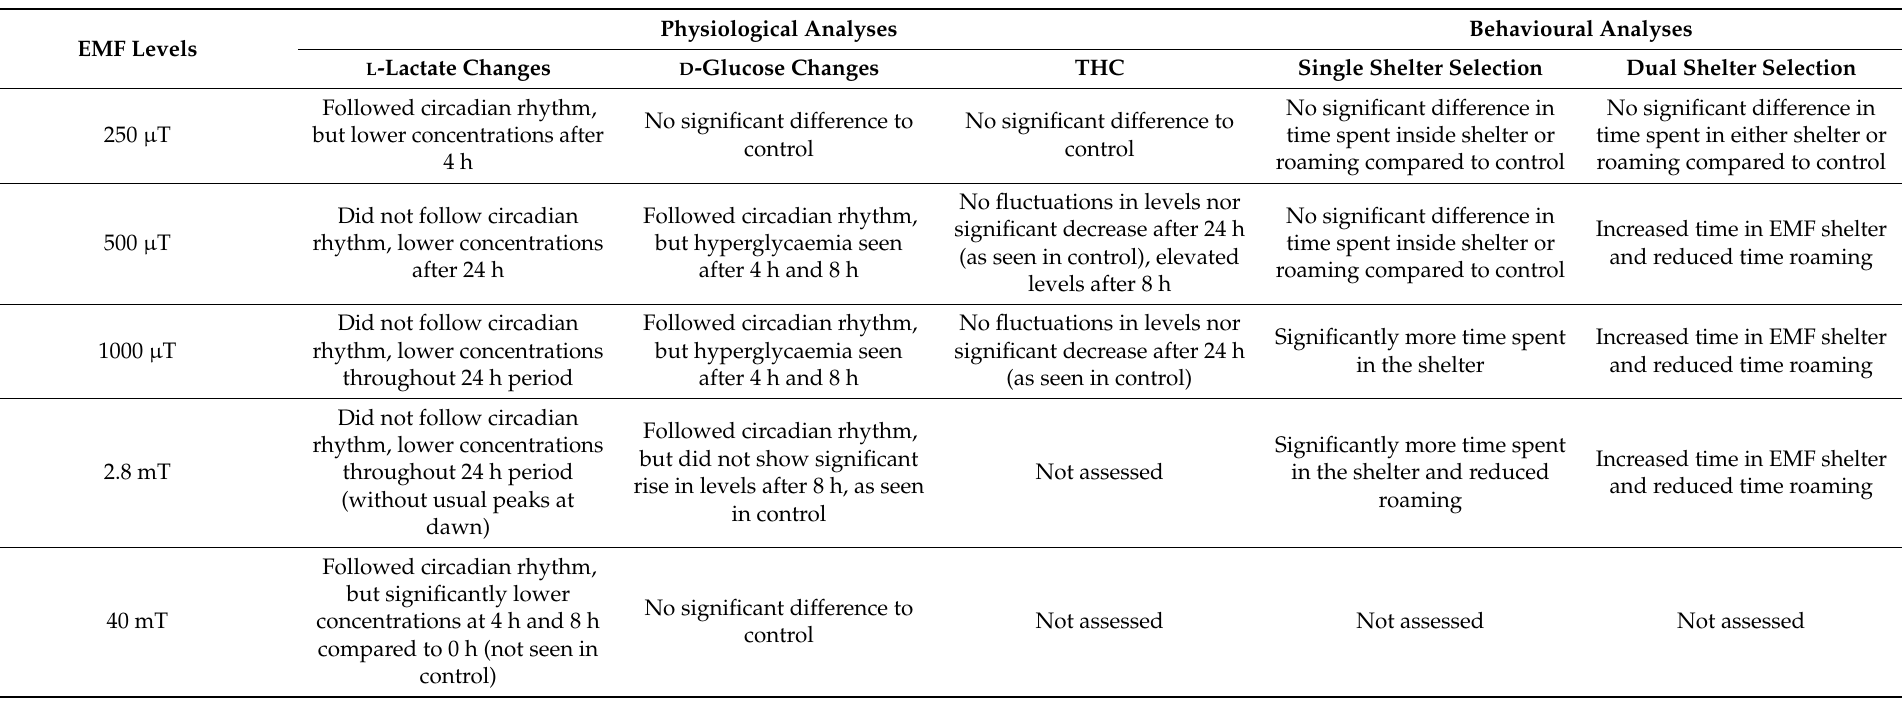
Table 1. Summary of the impacts of C. pagurus during exposure to multiple EMF strengths from the current study and Scott et al.